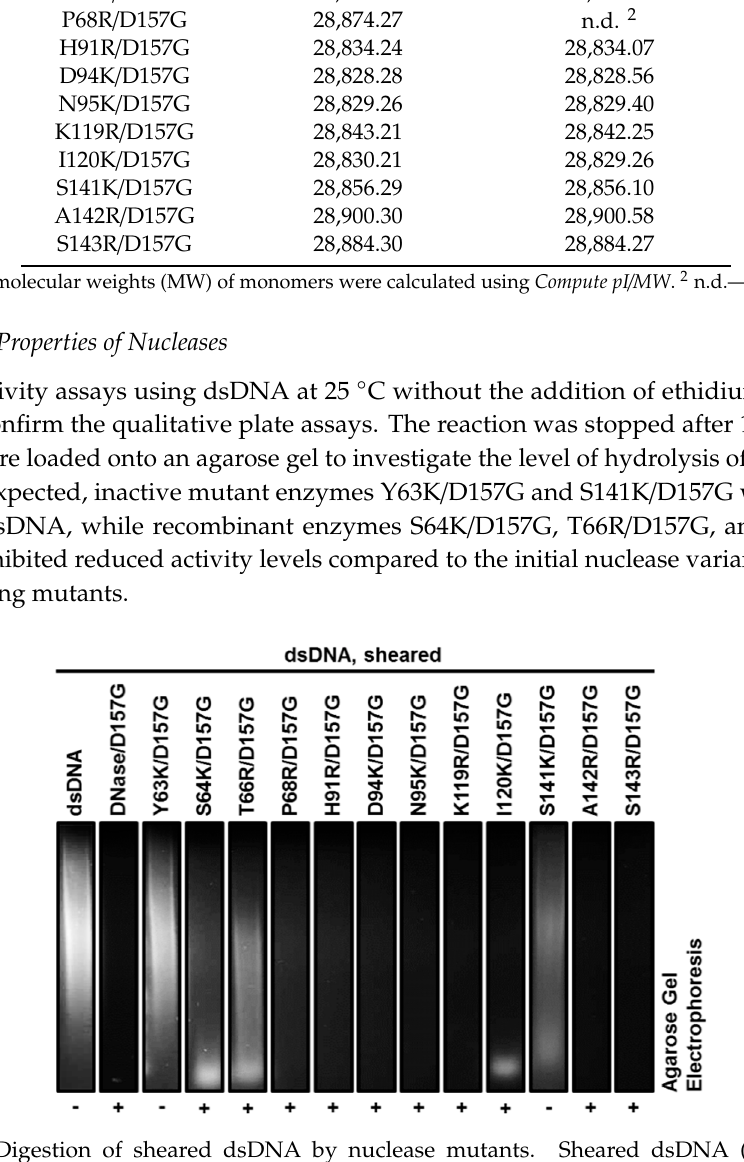
Table 1. Molecular masses of nuclease variants.